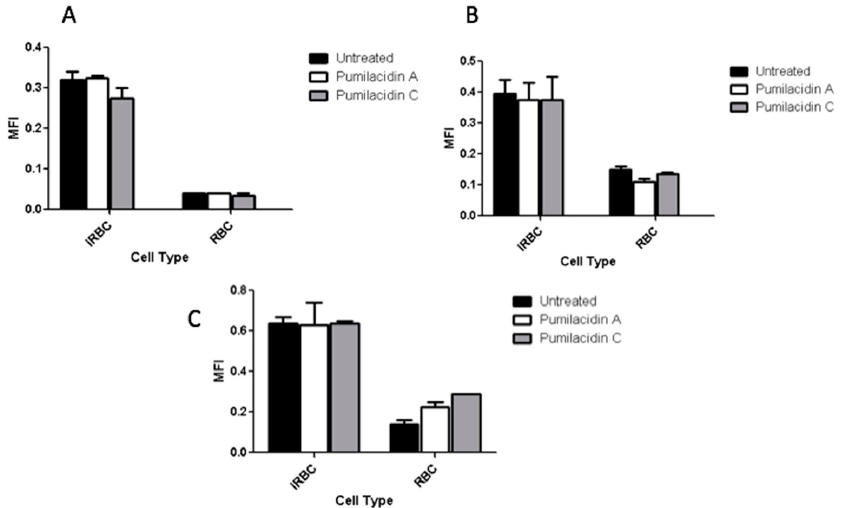
Figure 8. Reactive oxygen species (ROS) generation after surfactin treatment. After incubating P. falciparum parasites in the schizont stage with pumilacidins A and C at 10 μ M for different time points, the levels of ROS were measured at 3 h ( A ), 6 h ( B ), and 9 h ( C ) post treatment with surfactins.